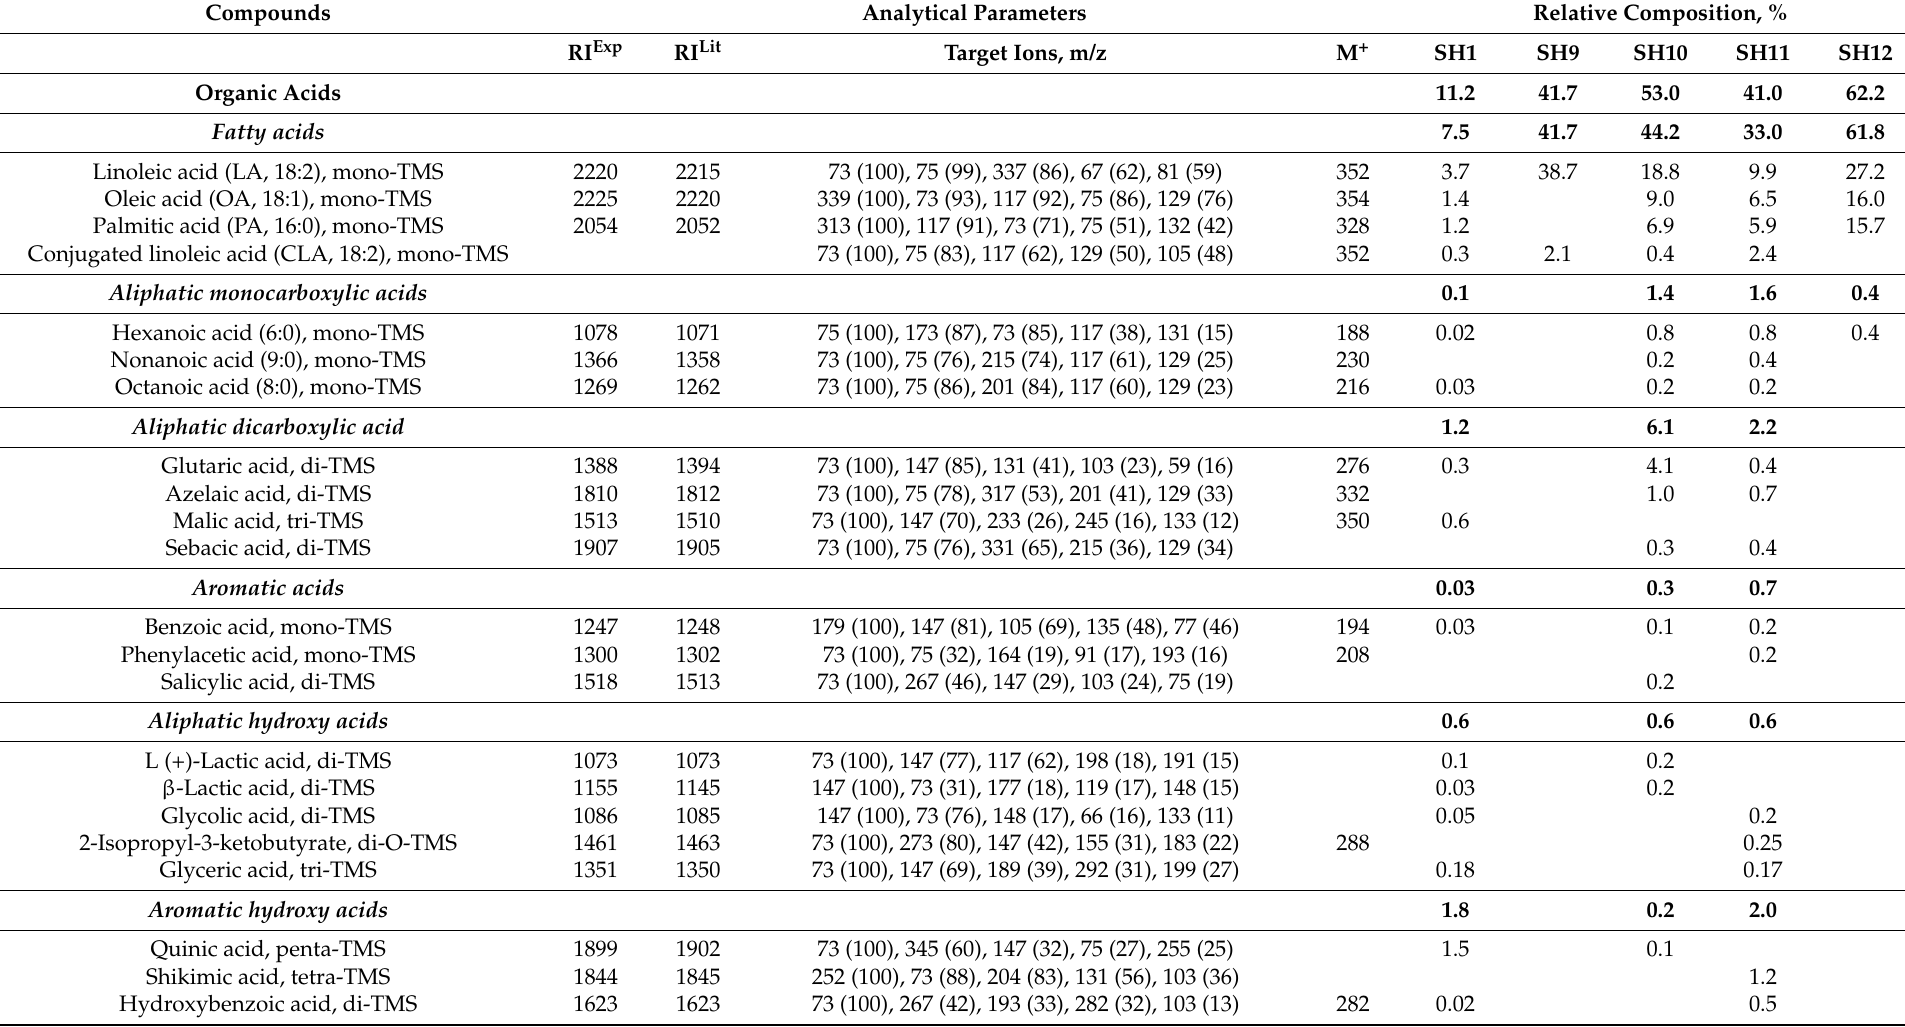
Table 1. GC-MS analysis of compound groups identified in SH1 , SH9 - SH12